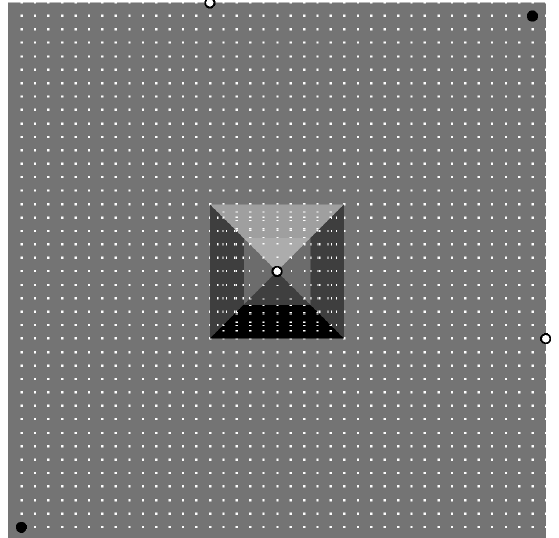
Figure 5: Two different survey planning results for the pyramid scene. Large white points: RSPs with removal order based on viewshed size. Large black points: RSPs with removal order based on mean line-of-sight incidence angle. The small white dots represent PSPs and VTPs simultaneously, since the same grid was used for the placement of both point types.